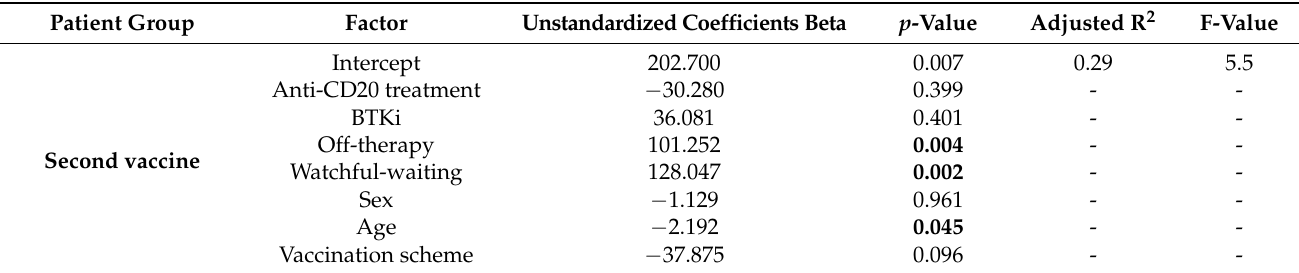
Table 2. Variables associated with the antibody response and seroconversion after the 2nd and 3rd anti-SARS-COV-2 S vaccinations in patients with B-cell malignancies ( n = 80). The multivariate regression analysis included oncological treatment (anti-CD19 CAR T-cell therapy, anti-CD20 therapy, BTK-inhibition, “off-therapy” and “watchful-waiting”), as well as sex, age and vaccination scheme ( homologous or heterologous ) of the patients. The intercept serves as the reference category, if all independent variables equal 0. Significant p -values are displayed in bold. BTKi: Bruton’s tyrosine kinase